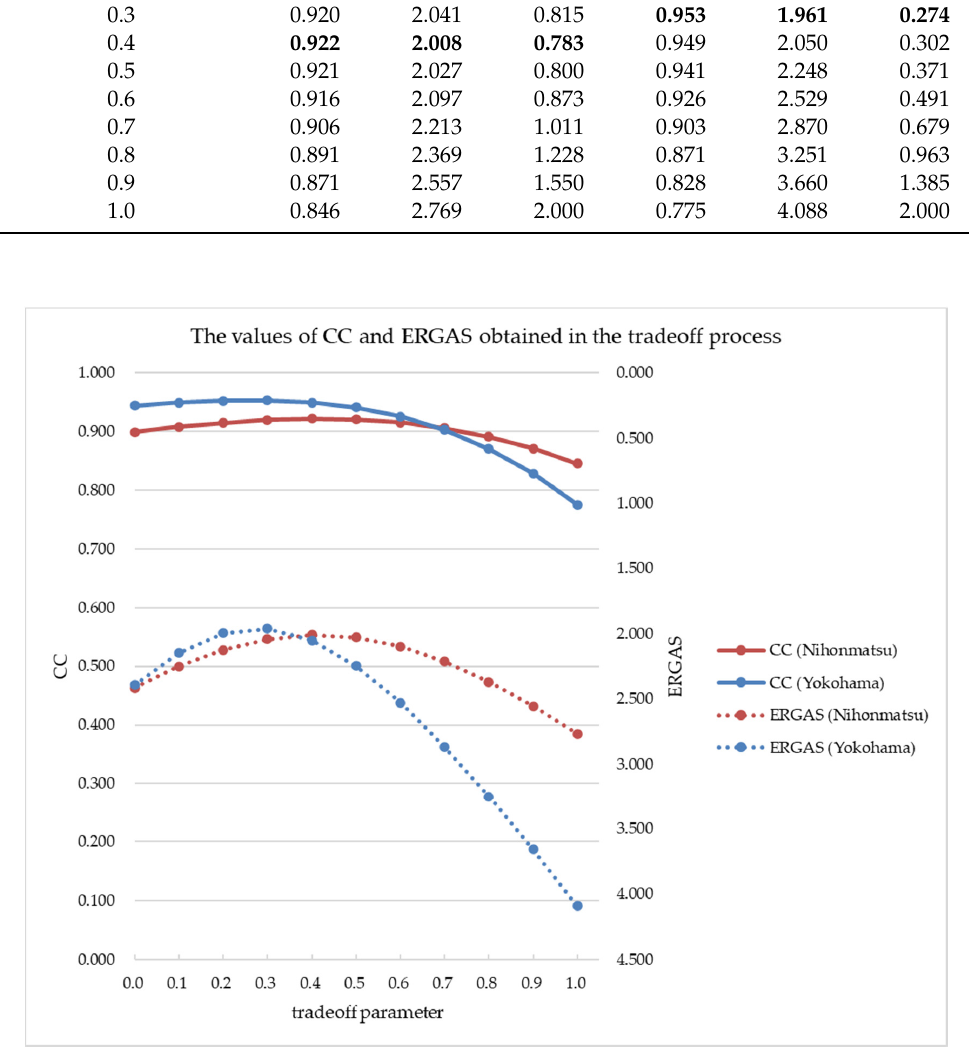
Figure 4. The values of CC and ERGAS obtained in the tradeoff process. CC: solid line, ERGAS: dotted line; Nihonmatsu: blue line, Yokohama: red line.